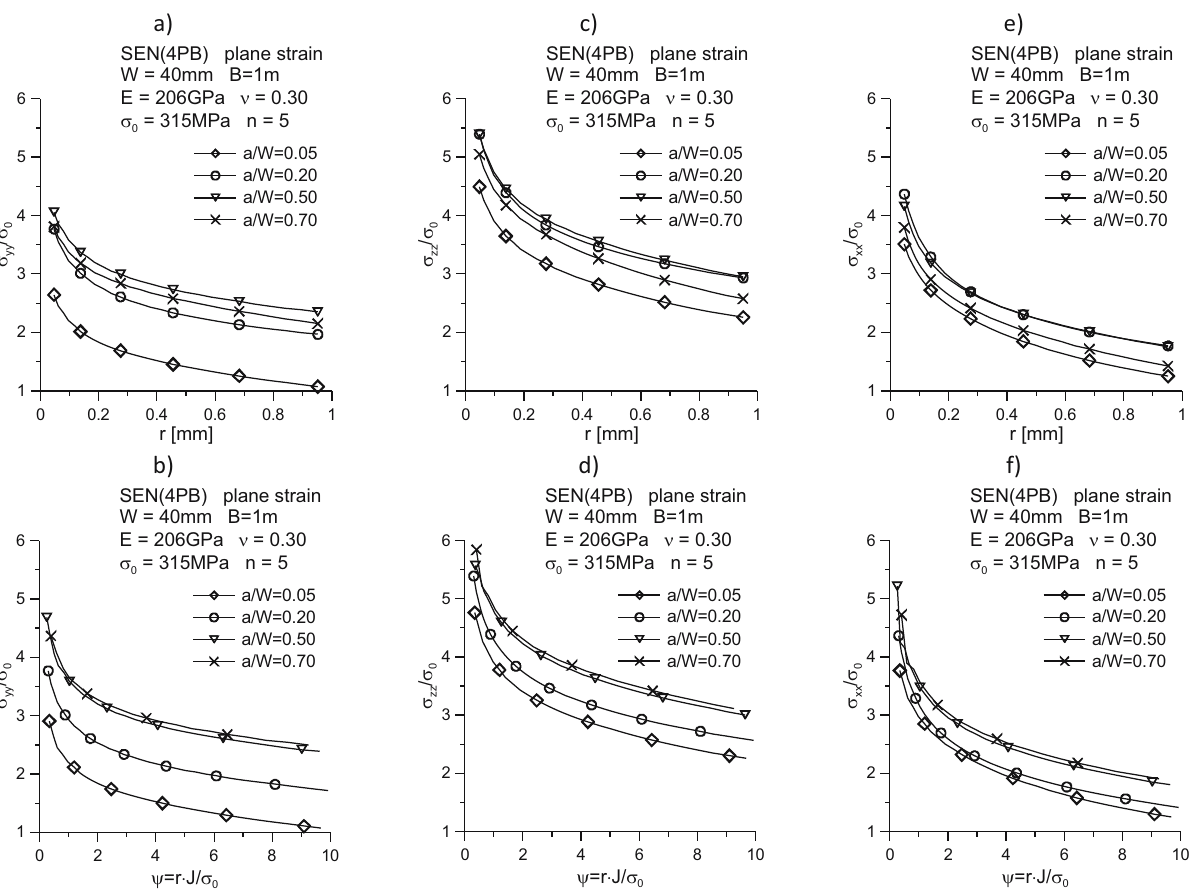
Figure 19: The in fl uence of the relative crack length a / W on the distribution of the main stress tensor components: components in the plane of crack propagation σ yy / σ 0 ( a and b ) and σ zz / σ 0 ( c and d ) and the component in the thickness direction ( along the crack front ) σ xx / σ 0 ( e and f ) in front of the crack tip ( graphs ( a, c, and e ) were prepared for the physical distance from the crack tip; graphs ( b, d, f ) were prepared for the normalized distance from the crack tip ψ = r · J / σ 0 ; the charts are presented for the moment when the external load reaches the limit load value – P / P 0 = 1.00; with the following values of the J integralfor subsequent specimens: a / W = 0.05, J = 31.0 kN/m; a / W = 0.20, J = 49.3 kN/m; a / W = 0.50, J = 29.3kN/m; a / W = 0.70, J =